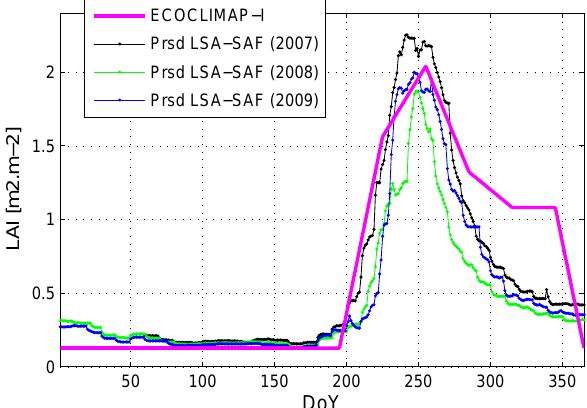
Fig. 3. Distribution of LSA-SAF LAI (continuous lines) against ECOCLIMAP-I monthly values (dashed vertical lines) for 3 dates (15 April, 15 August and 15 December 2007) for 3 homogeneous ecosystems: tropical African Grassland (top), Semi-Arid African grassland (middle) and Nile Valley and desertic crops (bottom).